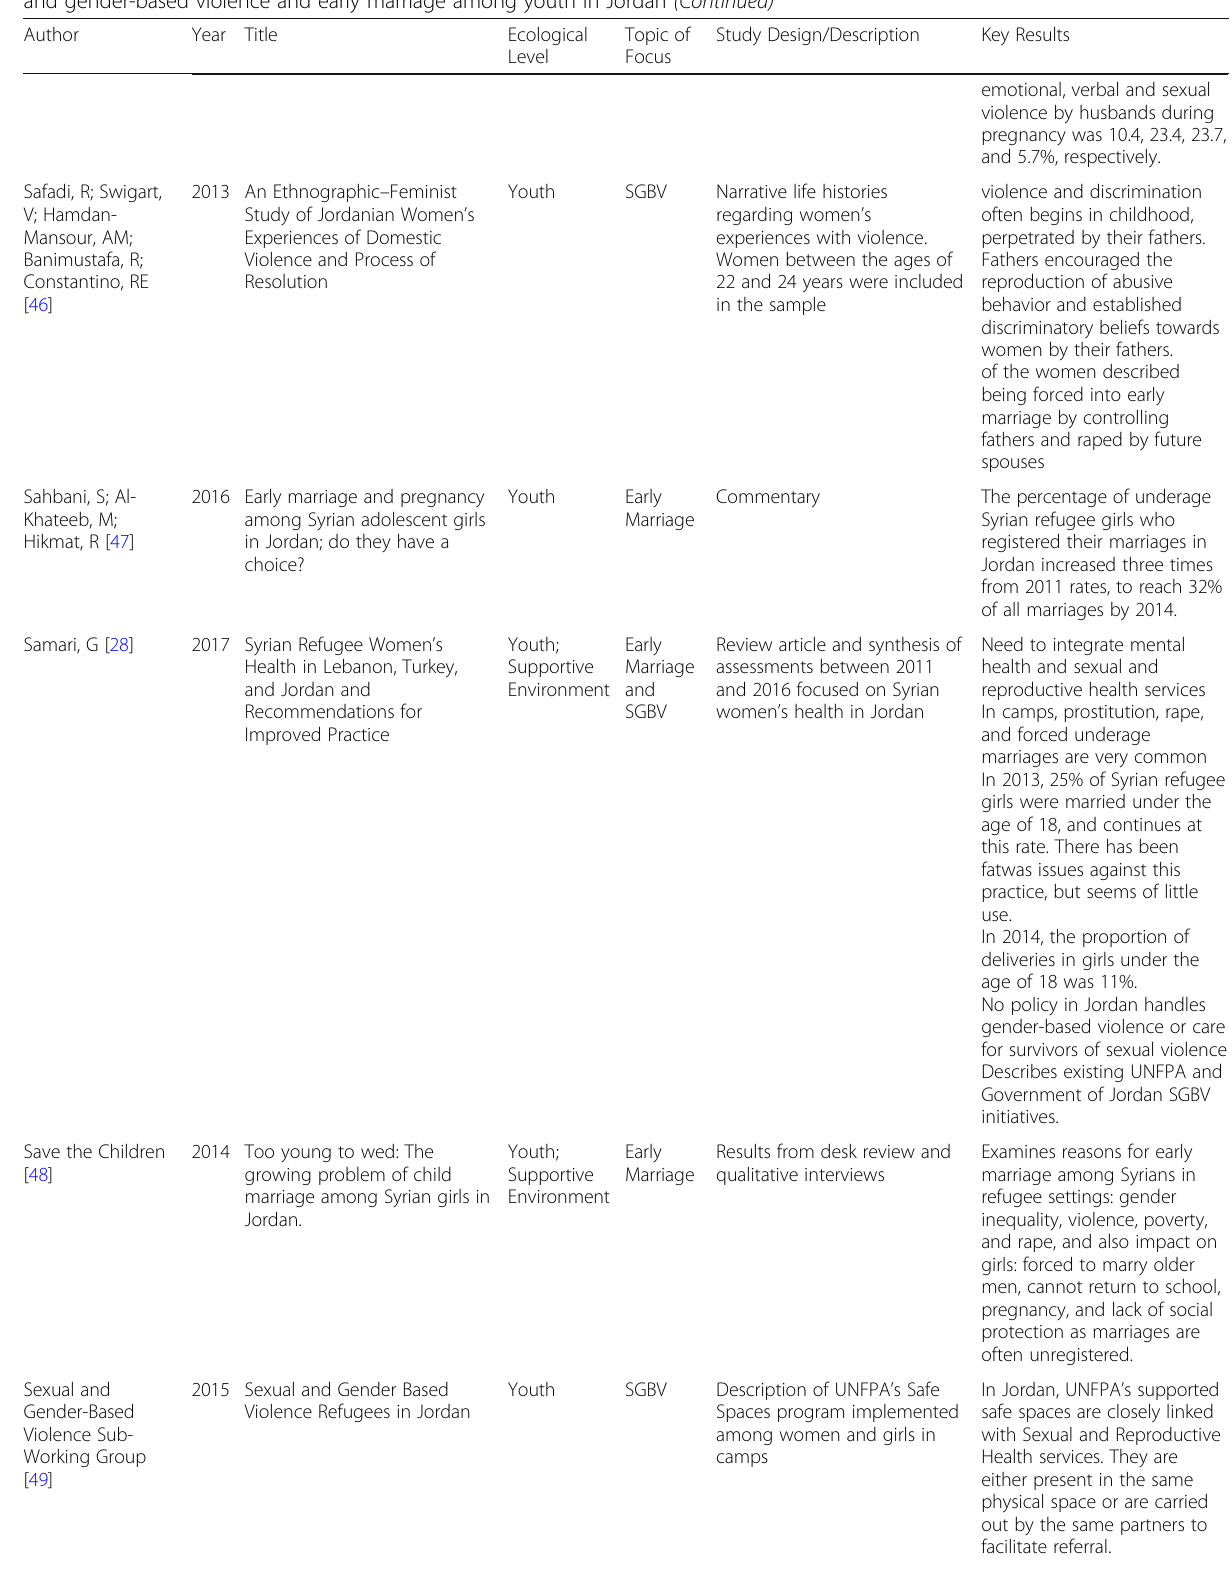
Table 1 Summary of the 27 documents included in the analysis according to ecological level and topic of focus pertinent to sexual- and gender-based violence and early marriage among youth in Jordan